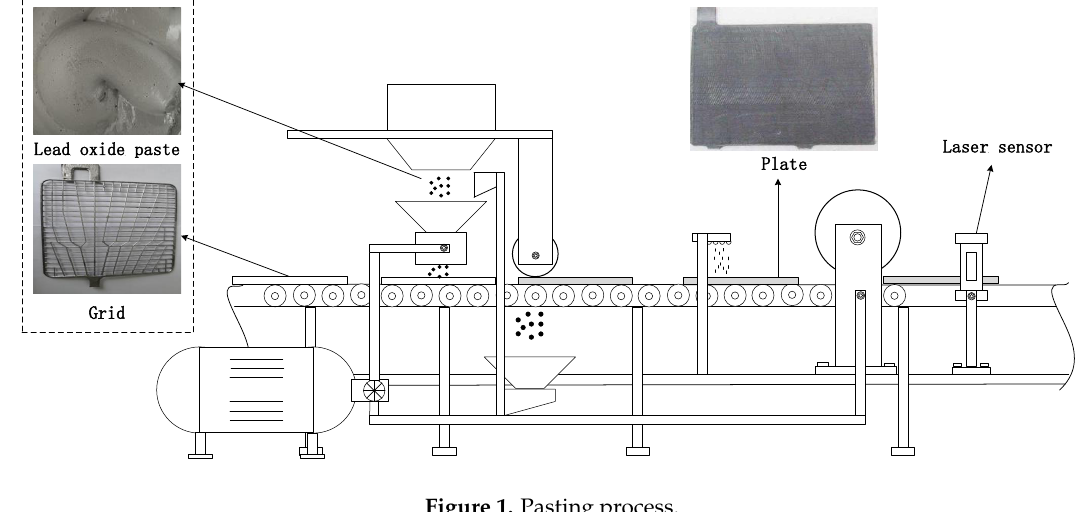
Figure 1. Pasting